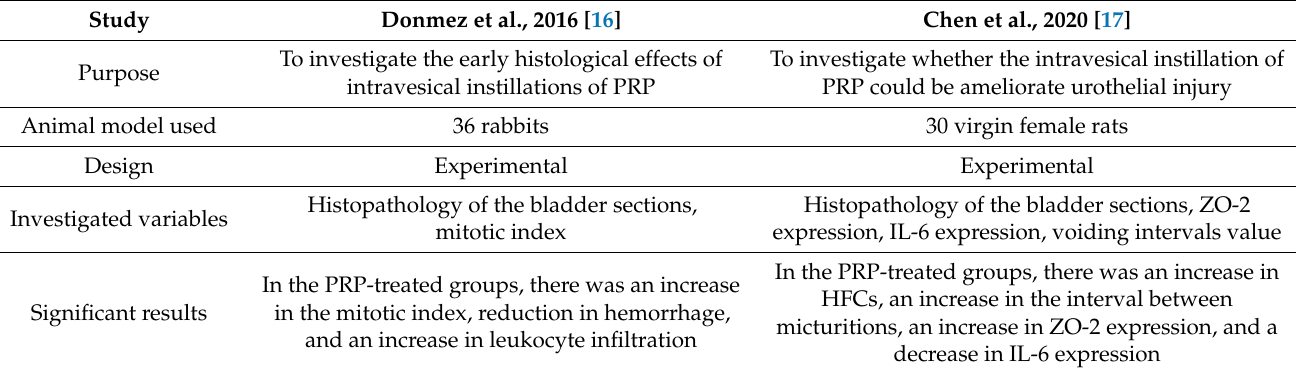
Table 1. Main features of the preclinical studies analyzed.